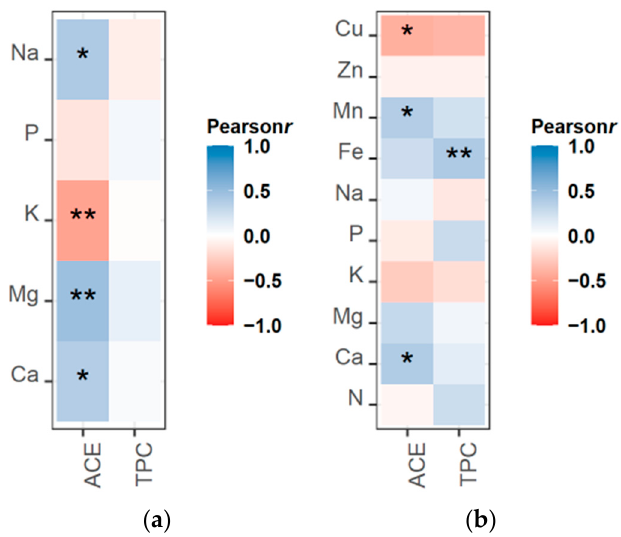
Figure 2. Correlogram representing Pearson’s correlation coefficient ranking of ACE and TPC with ( a ) the concentration of macronutrients in the inner leaf gel, and ( b ) the concentration of macronutrients and micronutrients in the outer leaf rind. Asterisks indicate the significance level of the correlation: * p < 0.05, ** p < 0.01.